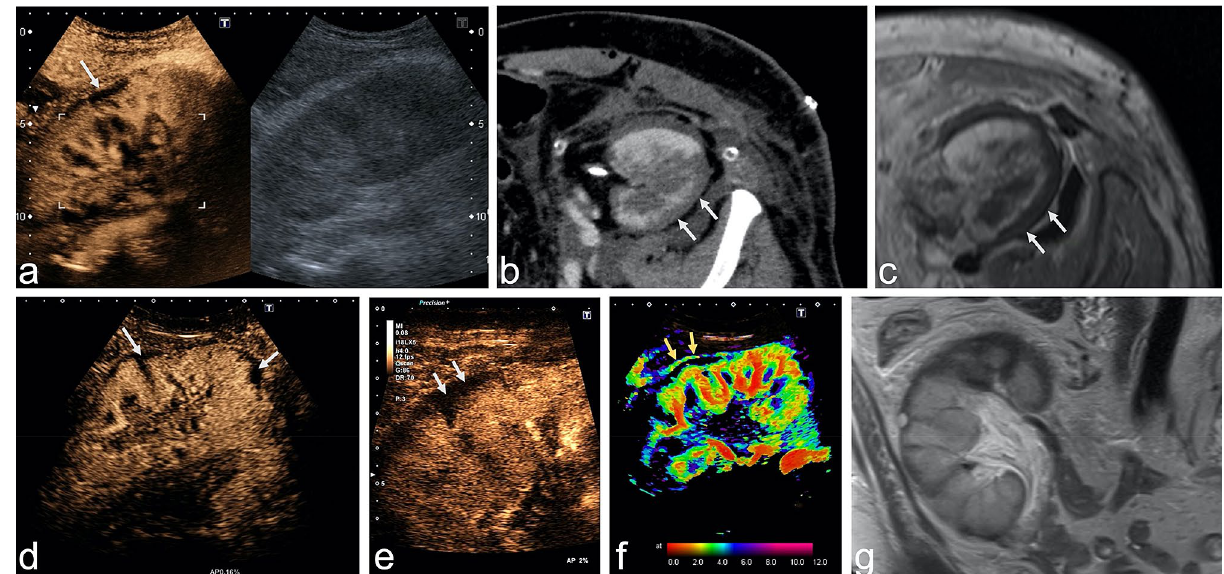
Figure 3. Comparison of modalities in the examination of a kidney transplant with suspected RCN. Upper row: Case showing partial RCN in a renal transplant in a 51-year-old man with end-stage renal failure due to shrunken native kidneys. ( a ) CEUS (0:59 min) and B-mode US of the renal transplant showing typical reverse rim sign with partial loss of enhancement in subcapsular cortex. ( b , c ) CeCT ( b ) and ceMRI ( c ) showing the hypoenhanced rim of the renal cortex in the transverse plane. Lower row: A case of RCN in a 54-year-old woman with renal transplant. ( d ) CEUS (1:13 min) using a convex multifrequency probe clearly identifies the reverse rim sign as a nonenhanced rim in the superficial cortex and lower pole (arrows). ( e ) Increased spatial resolution by use of a linear probe, which is important for second look if CEUS with convex probe shows inconclusive findings. ( f ) Parametric arrival time imaging of CEUS depicts arterial inflow in interlobar arteries and cortex within 4 s (red and green). Arrows indicate the so-called cortical rim sign with preserved blood supply by capsular arteries (arrows). ( g ) Coronal T2w MR image confirms the cortical structure defect and moreover shows cortical perfusion deficit at the upper pole of the renal transplant. RCN denotes renal cortical necrosis; CEUS, contrast-enhanced ultrasound; ceCT, contrast-enhanced computed tomography; ceMRI, contrast-enhanced magnetic resonance imaging.